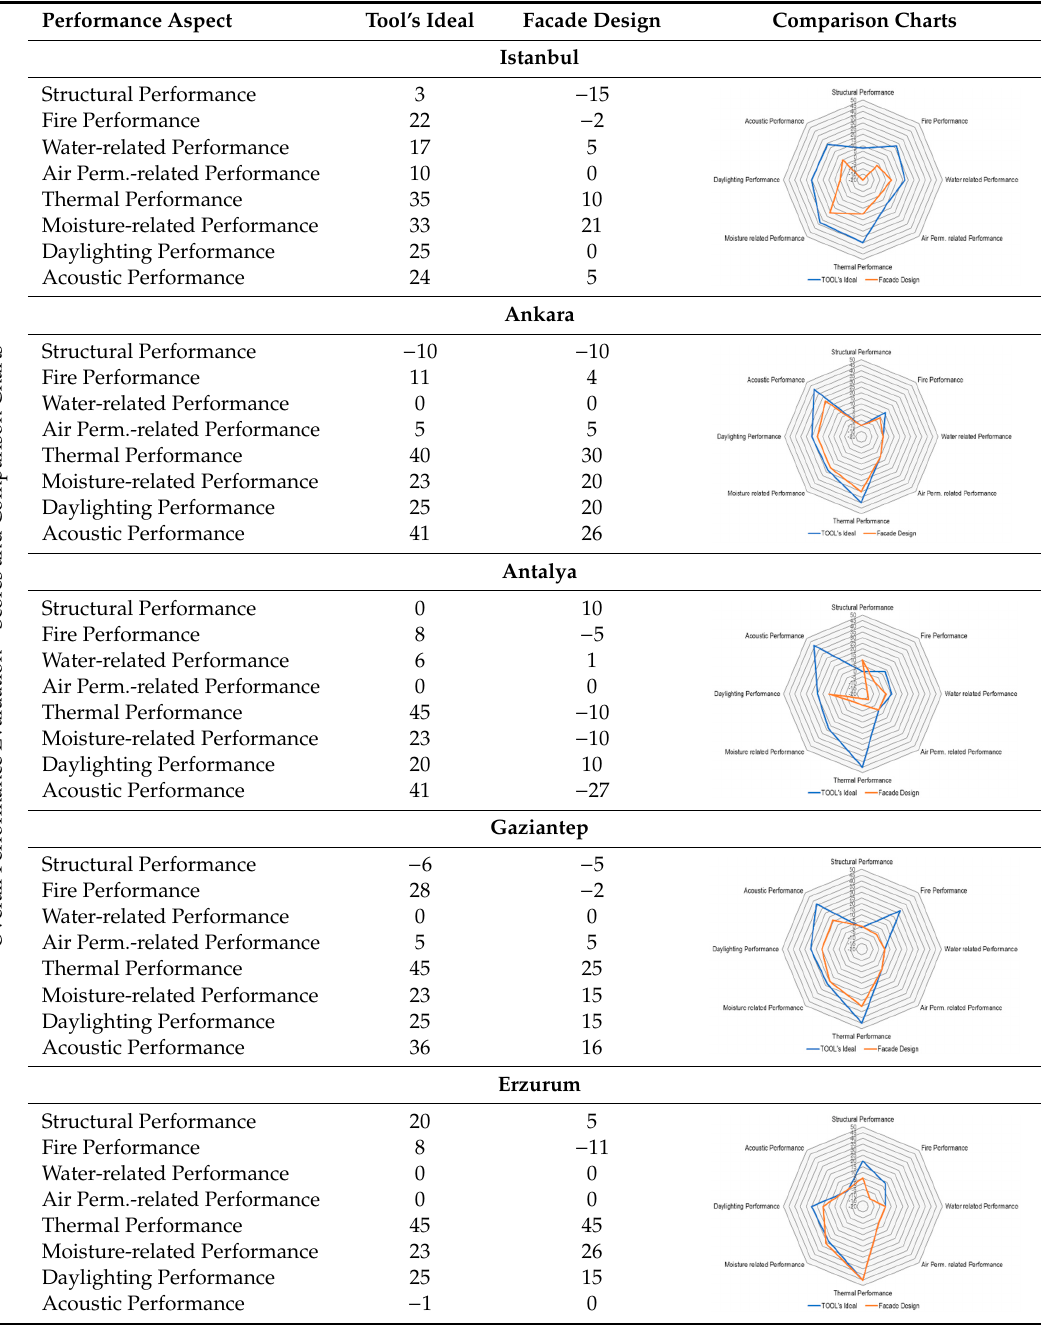
Table 8. Overall performance evaluation for all scenarios as scores and comparison charts.